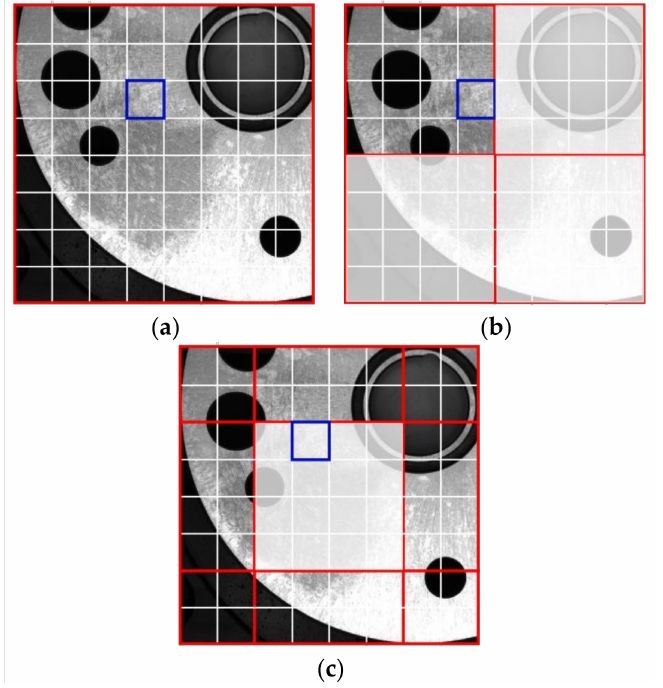
Figure 5. Schematic diagrams of ( a ) MSA, ( b ) W-MSA and ( c )